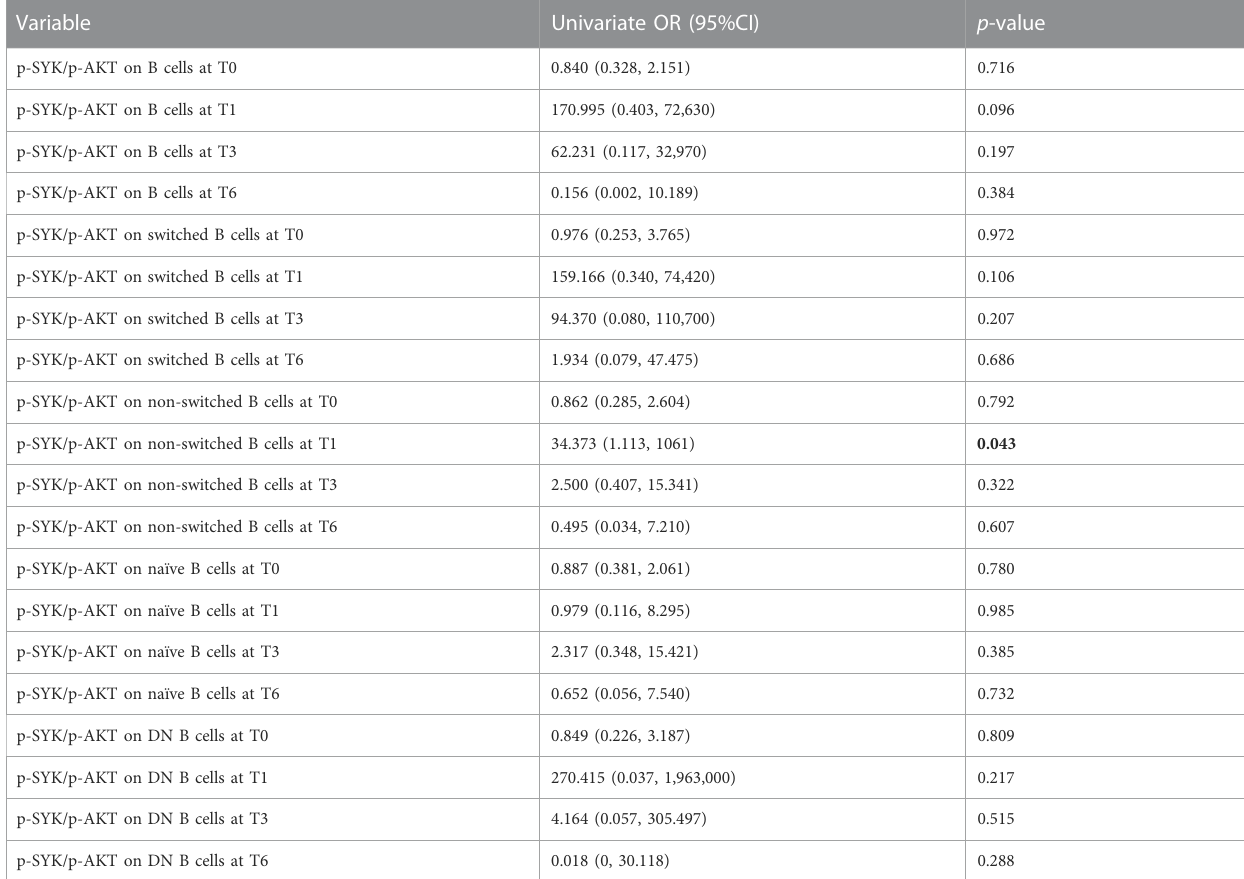
TABLE 2 Association between the ratio of p-SYK/p-AKT at 1 month and SLEDAI-2K decline rate by univariate analysis in the SLE patients.